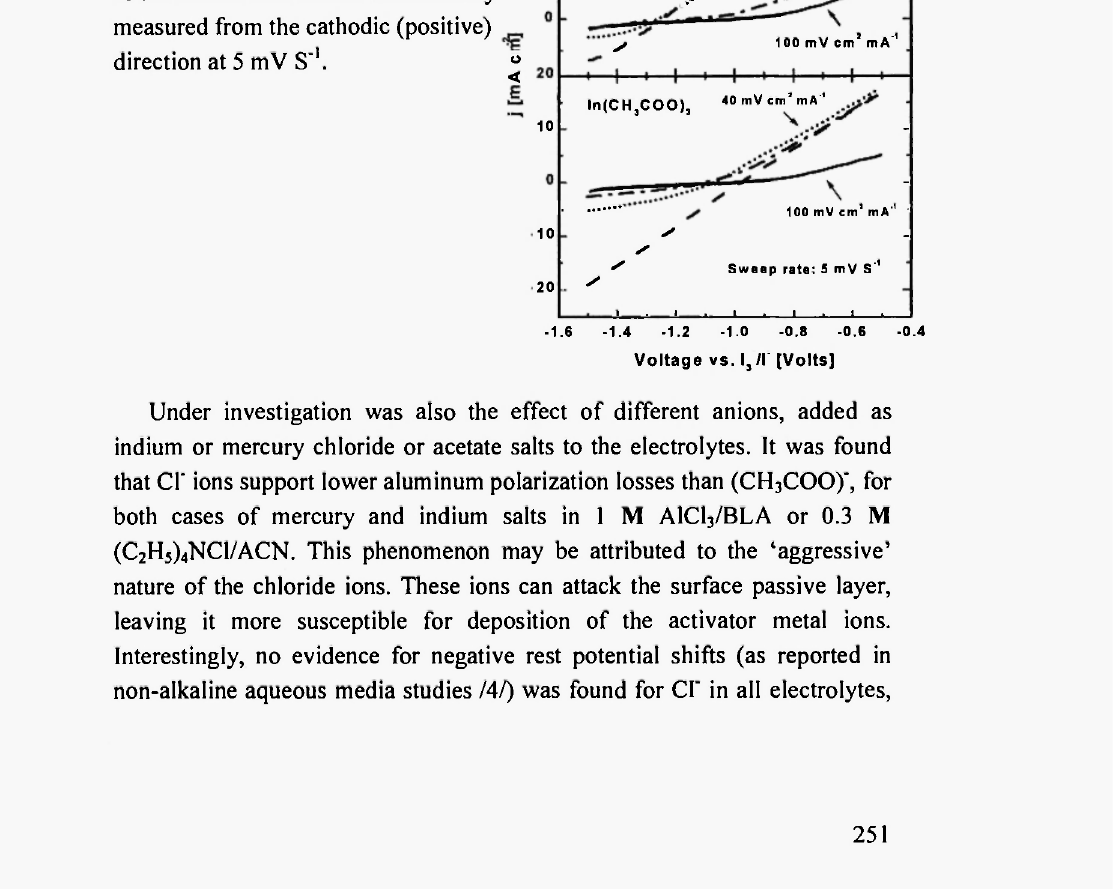
Figure 2. Concentration dependence of Hg(II) (top) and In(IlI) (bottom) on aluminum activation. In each case the activator is added to 1 Μ A1C1 3 /BLA as the acetate salt. Linear voltammetry measured from the cathodic (positive) direction at 5 mV S" 1 .